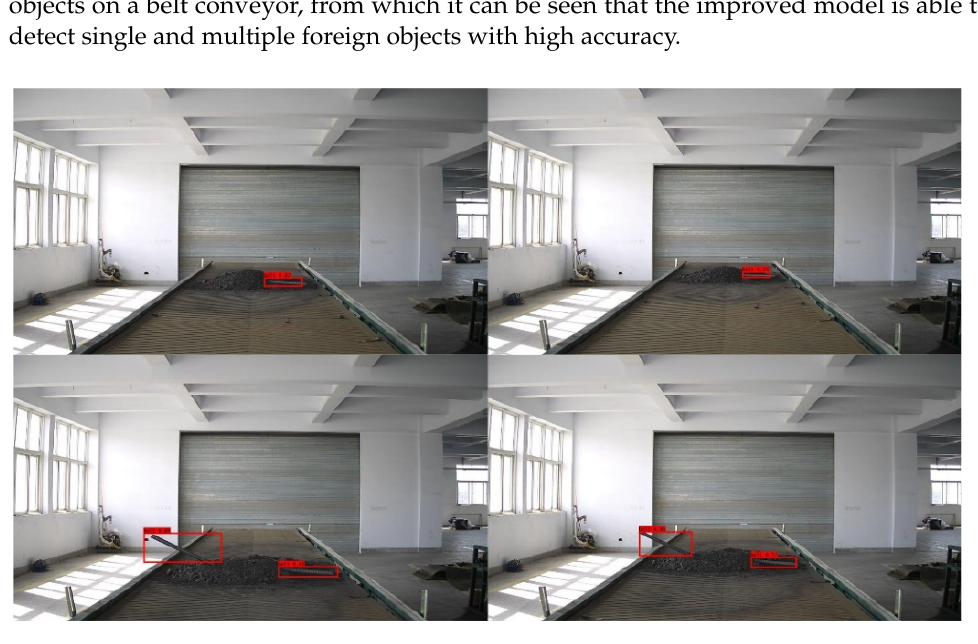
Figure 26. Semi-buried gangue detection.